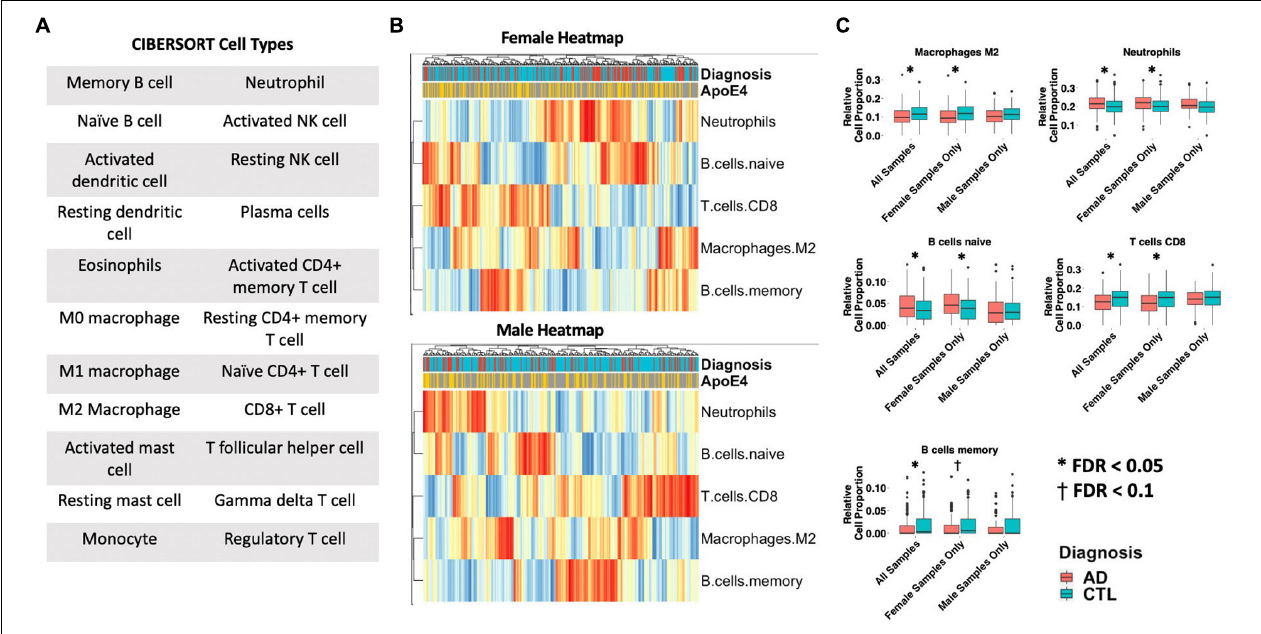
FIGURE 5 | Cell type analysis in whole blood. (A) Cell types included in the panel of 22 reference cell types in CIBERSORT. (B) Heatmap depicting cell type expression between cases and controls. APOE ε 4 carrier status, sex, and case/control status is annotated for each sample. Only cell types that are significantly different between cases and controls in pooled male and female, male-only or female-only analyses are shown. (C) Bar charts depicting cell type expression for individual cell types that are significantly between cases and controls in pooled male and female, male-only or female-only analyses are shown. Significance was assessed by associated cell type proportion to case/control status, adjusting for age, sex (in the pooled male and female model) and APOE ε 4 status. P < 0.05 was deemed